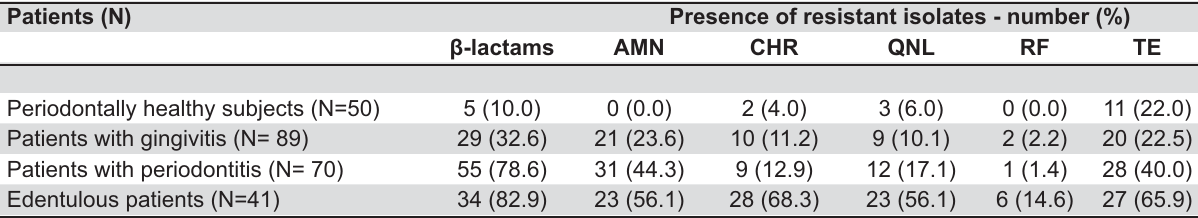
AMN, aminoglycosides; CHR, chloramphenicol; QNL, quinolones; RF, rifampin; TE,